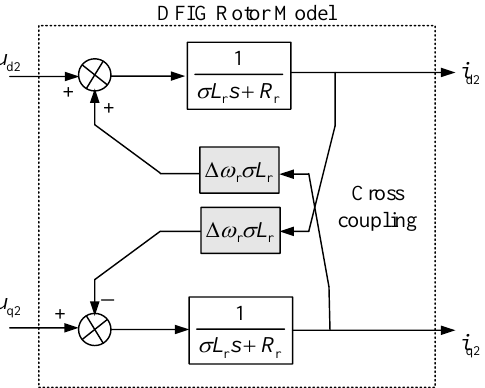
the disturbance term is offset by the controller’s compensation as shown in Figure 6.